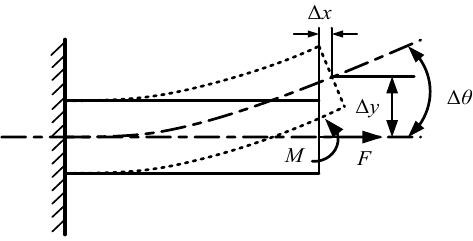
Figure 4. The working principle of the flexure hinge.